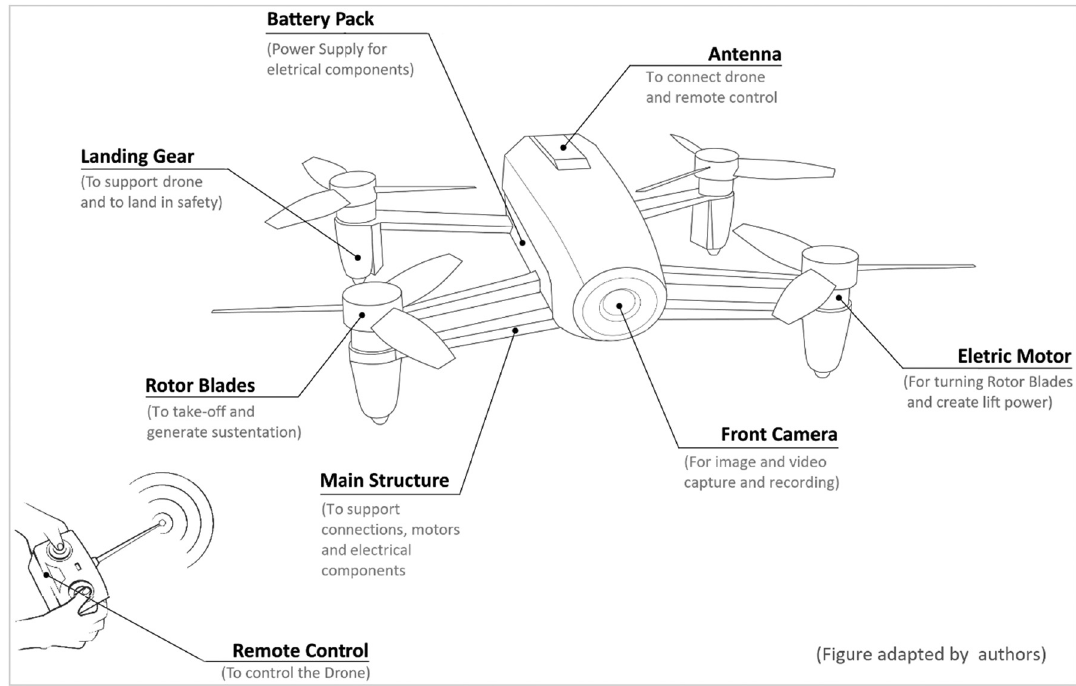
Figure 1: Scheme of the main physical parts of drones in